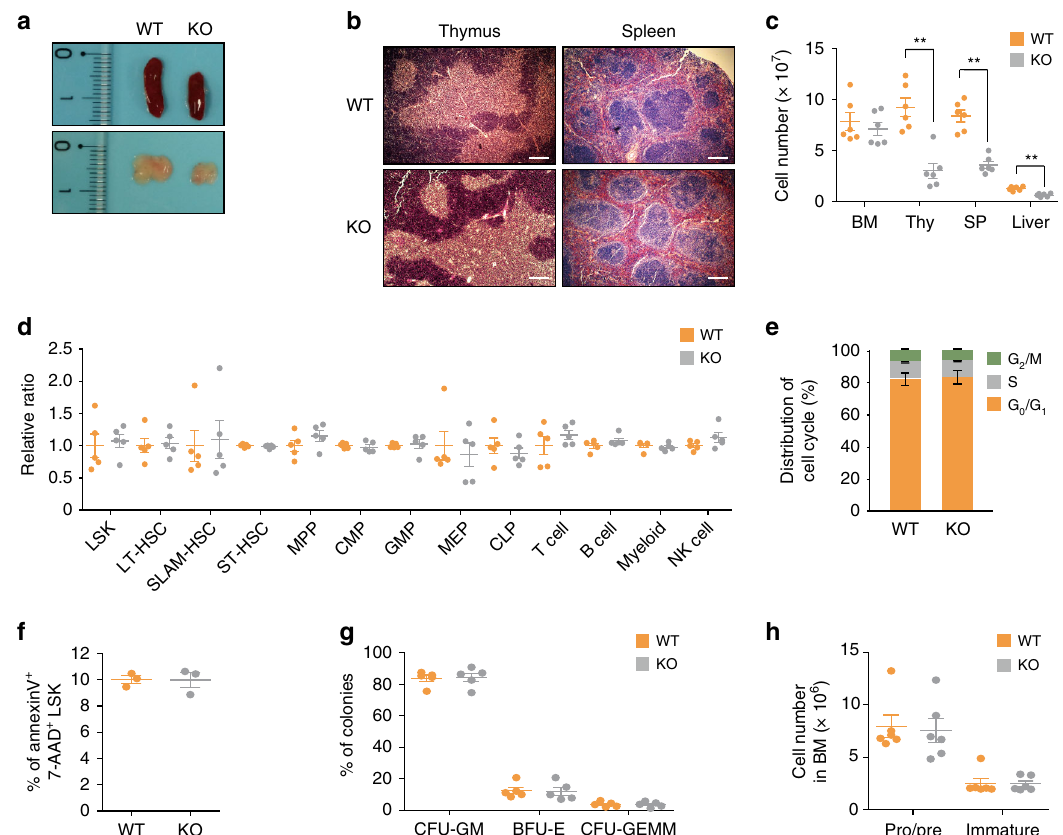
Fig. 1 Phc2 de fi ciency leads to immune cell de fi ciency without intrinsic defects in HSPCs. a Representative images of spleens and thymi from WT and KO mice. n = 6. b Normal architecture of the thymus and spleen of the KO mouse. Representative hematoxylin and eosin staining images of spleens and thymi from WT and KO mice. n = 6. Scale bars: 200 μ m. c Absolute number of immune cells in the BM, thymus (Thy), spleen (SP), and liver of WT or KO mice. n = 6. d Relative ratio of BM-resident hematopoietic lineage cells between WT and KO mice. n = 5. LSK, Lin − Sca-1 + c-kit + cells; LT-HSC, long-term HSC; SLAM-HSC, Lin − CD41 − CD48 − CD150 + cells; ST-HSC, short-term HSC; MPP, multipotent progenitors; CMP, common myeloid progenitors; GMP granulocyte/monocyte progenitors; MEP, megakaryocyte/erythrocyte progenitors; CLP, common lymphoid progenitors; Myeloid, myeloid cells. e Cell cycle status of BM-resident LSK cells from WT and KO BM. n = 4. f Percentage of apoptosis for BM-resident LSK cells from WT and KO mice. n = 3. g BM- resident clonogenic progenitors from WT and KO mice were assessed by CFU assays. n = 5. CFU-GM, CFU-granulocyte and/or macrophage; BFU-E, erythroid burst-forming units, CFU-GEMM, CFU-granulocyte/erythrocyte/monocyte/megakaryocyte. h Absolute number of BM-resident B cell subpopulations from WT and KO mice ( n = 6). Pro/pre, pro-B cells/pre-B cells; Immature, immature B cells. Statistical signi fi cance was assessed by two- tailed Student ’ s t -test. ** P < 0.01. All data are presented as the mean ± SEM. Source data are provided as a Source Data